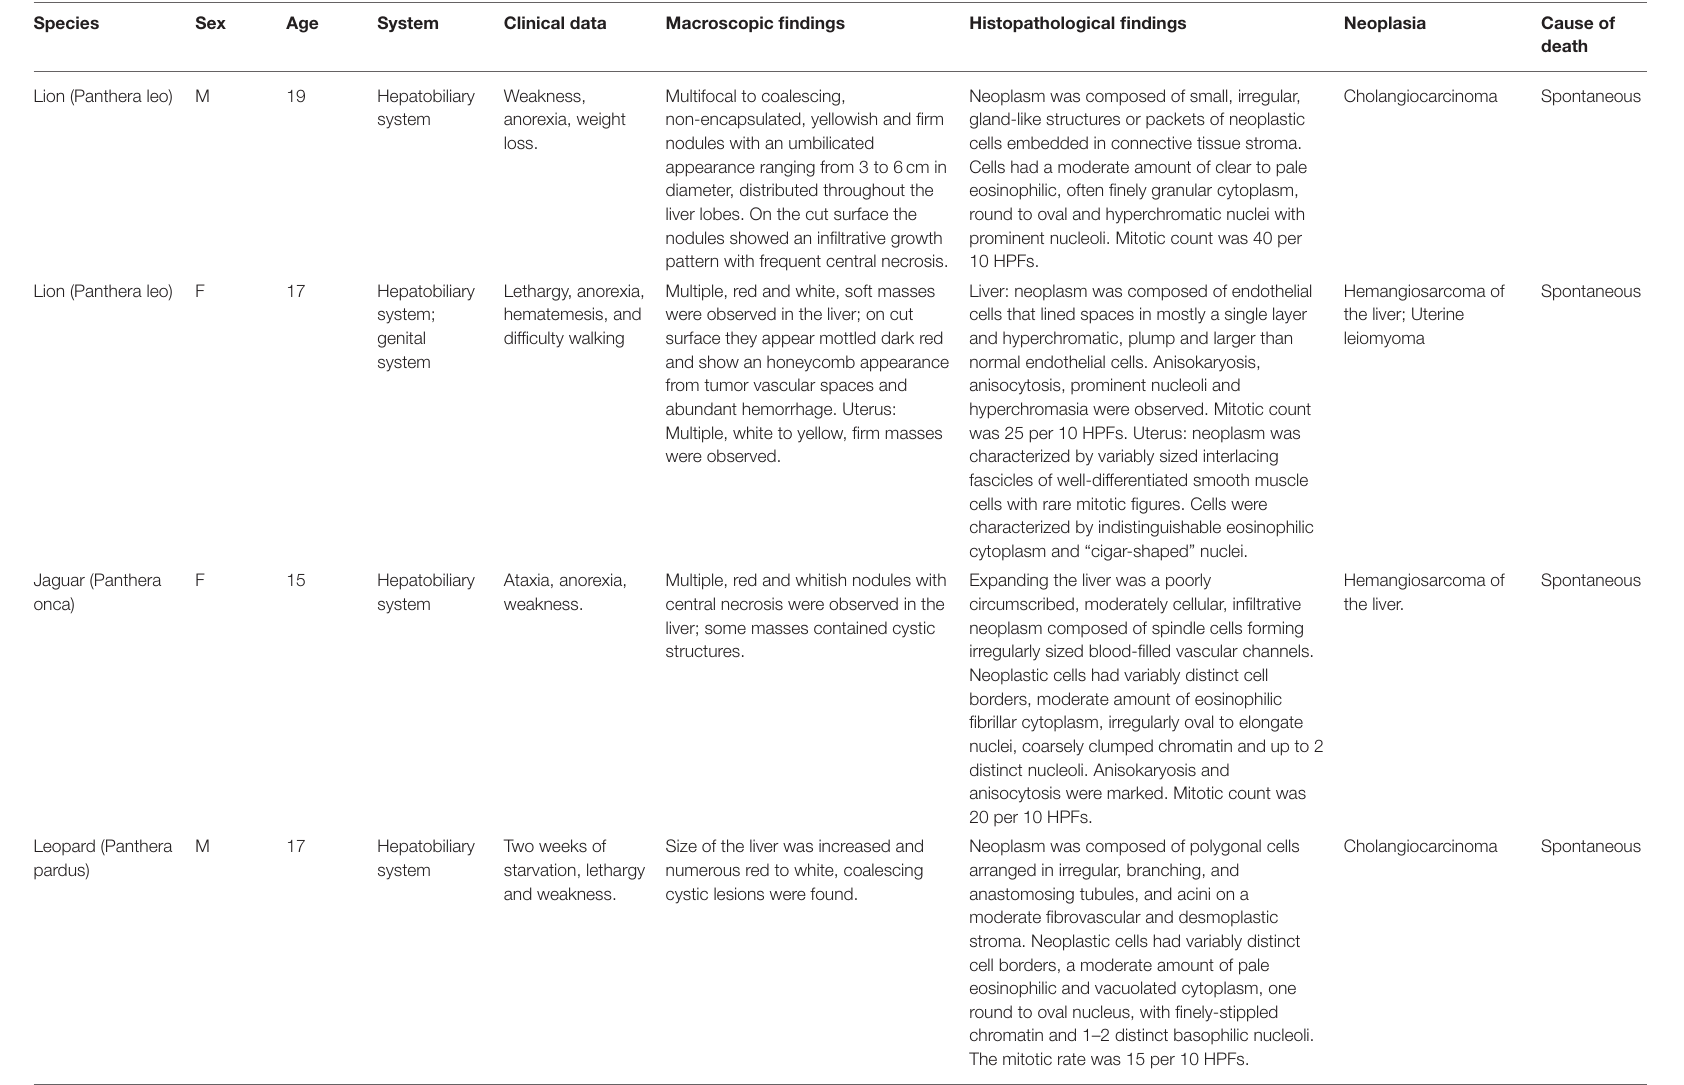
TABLE 1 | Summarized results about species, sex, age, organ system, clinical backgrounds, macroscopical and microscopical findings, type of neoplasia, and cause of death.